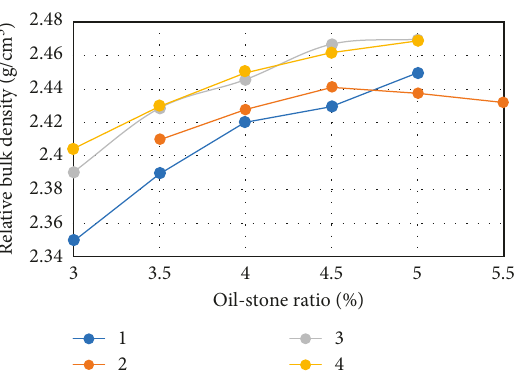
Figure 4: Relation between AC-16 saturation and oil-stone ratio.